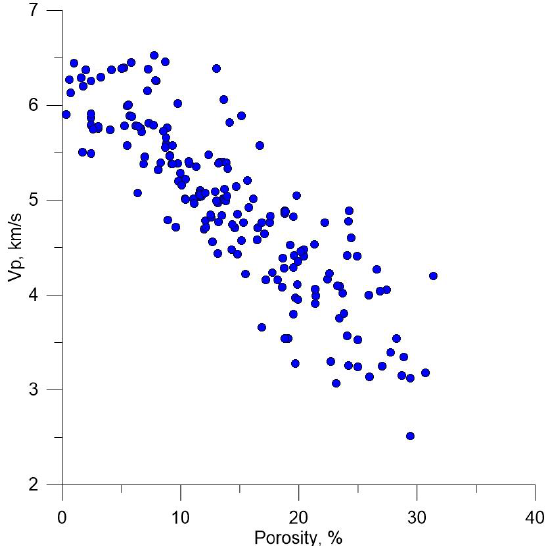
Figure 1. P-wave velocity vs. porosity for carbonates located in the South Tatar arch.